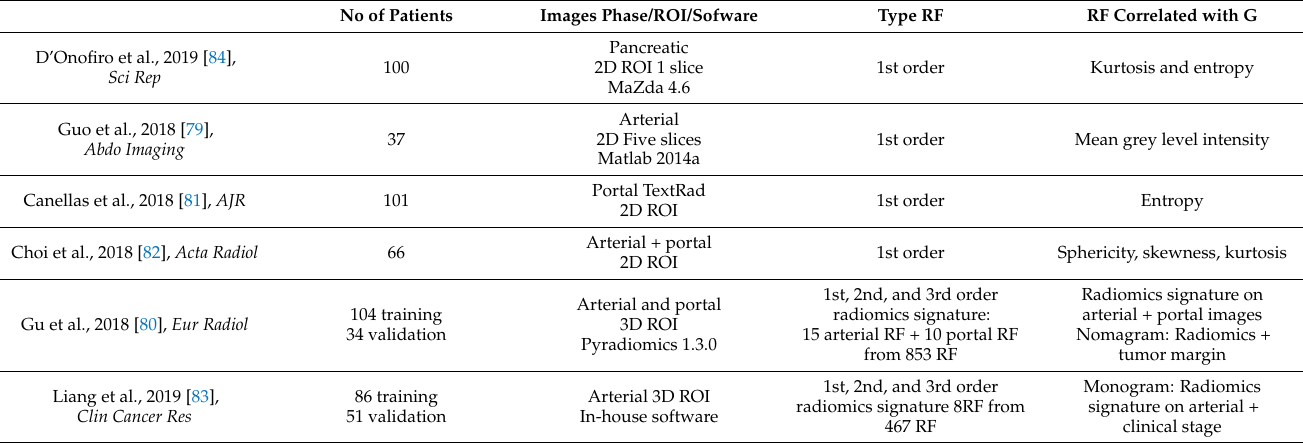
Table 1. Published papers on the value of CT texture analysis in predicting the grade in